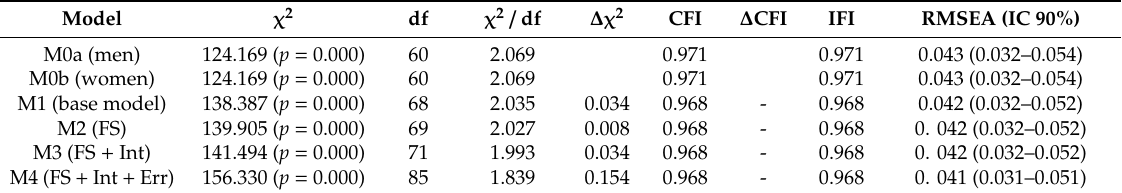
Table 4. Multigroup analysis of invariance across sex (men /